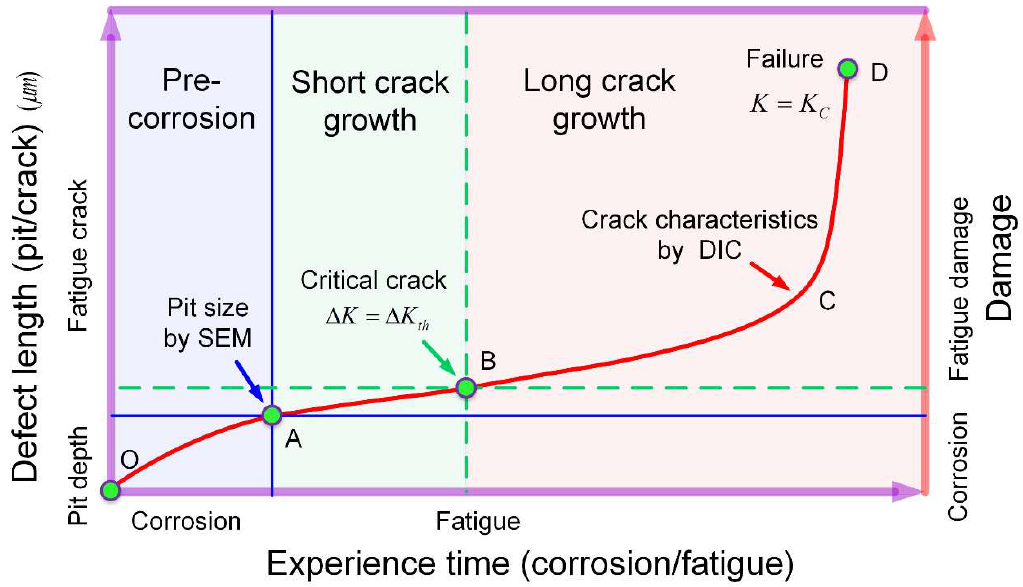
Figure 14. Different stages in pre-corroded fatigue failure process of aluminum alloy.